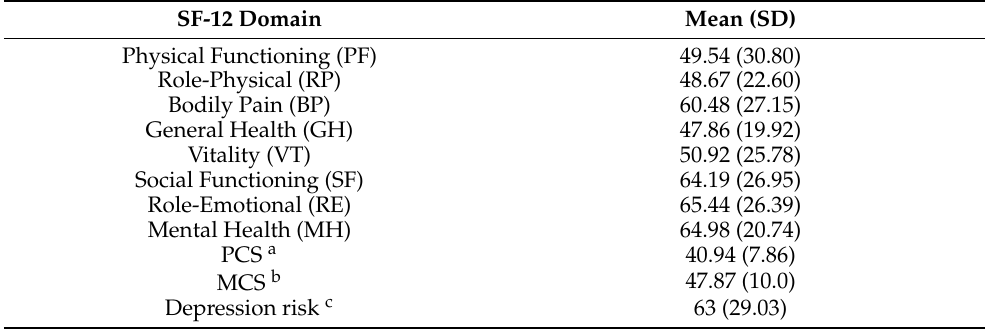
Table 2. Results of SF-12 domains and depression risk prevalence as derived from the MCS